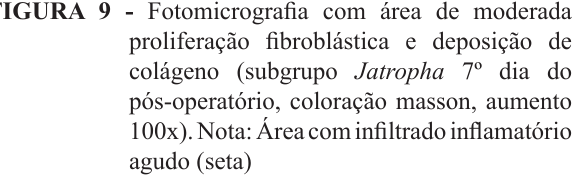
FIGURA 6 - Animais dos dois subgrupos, segundo a variável neoformação vascular capilar e angiogênese